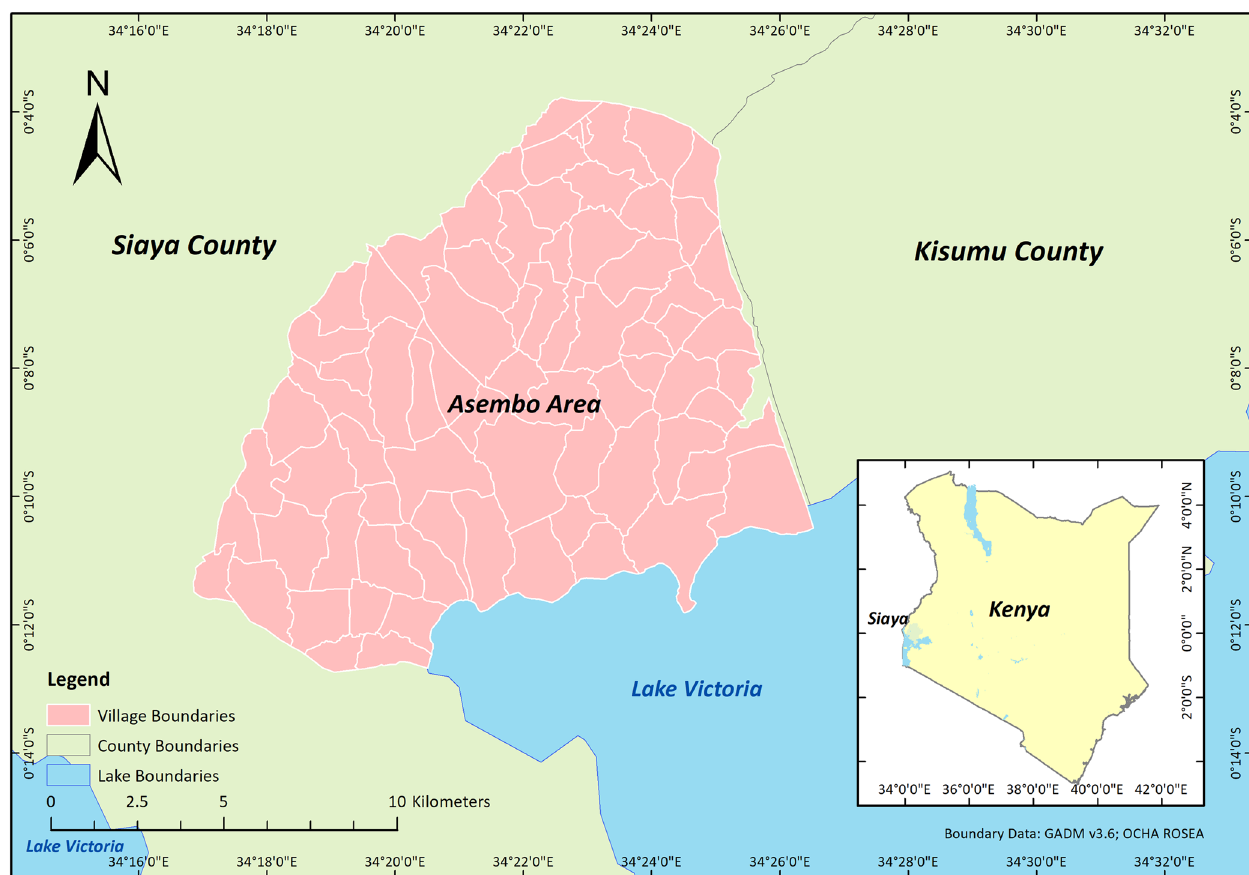
Fig. 1 Map of the Asembo study area in Siaya County, western Kenya. The inset map shows the location of Siaya County (in green) in